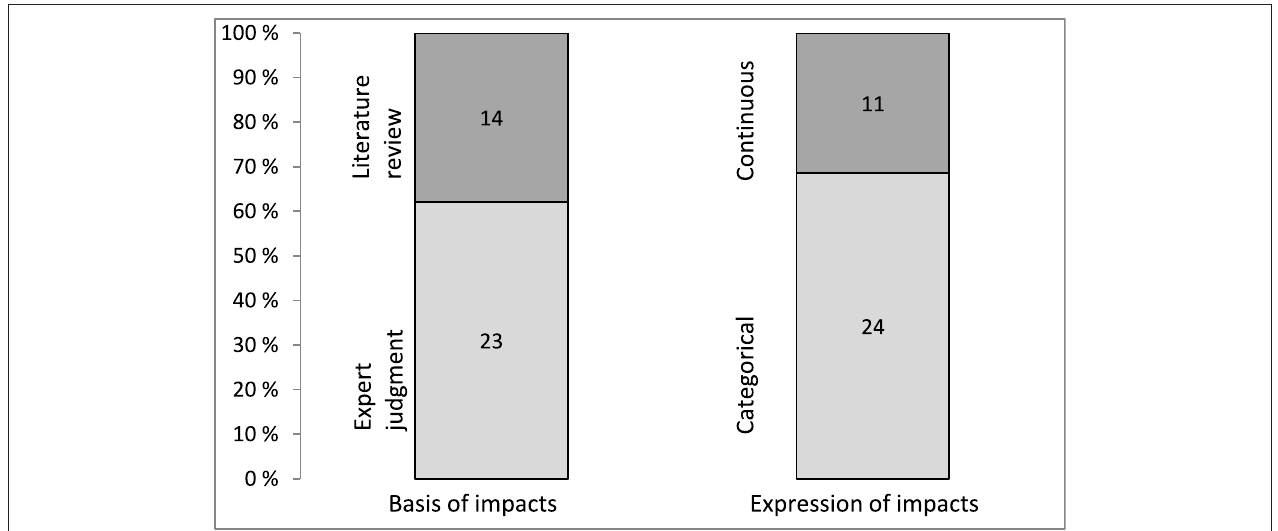
FIGURE 4 | Differences in estimating and expressing impacts of anthropogenic pressures. The impact estimates are based on expert judgment or literature (including models where the interactions are literature-based). The impacts are expressed on categorical scales and on continuous scales. Note that the numbers also include those studies where “impacts” are not specific to ecosystem components but used to weight pressures. Two of the studies used both literature and expert judgment as the